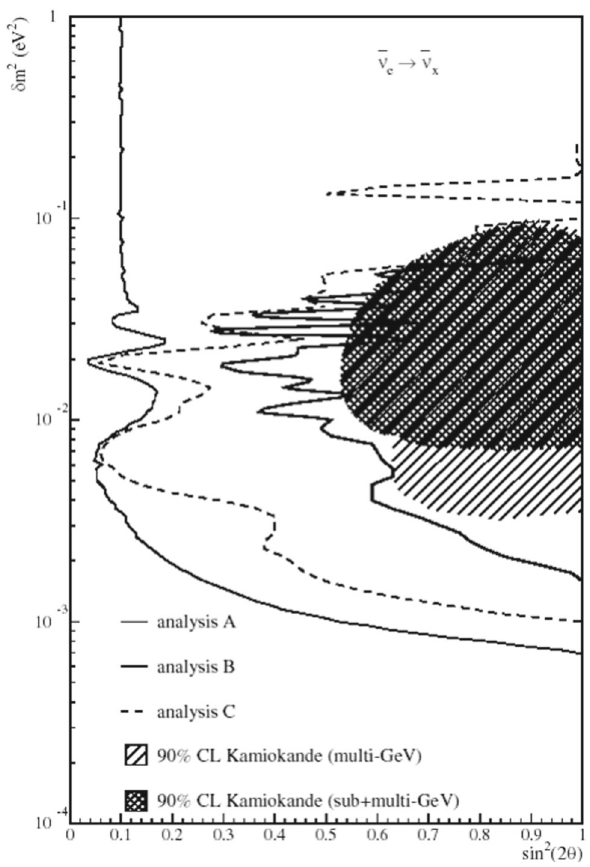
Fig. 37 Excluded region of ν e disappearance in reactor experiment by CHOOZ [49]